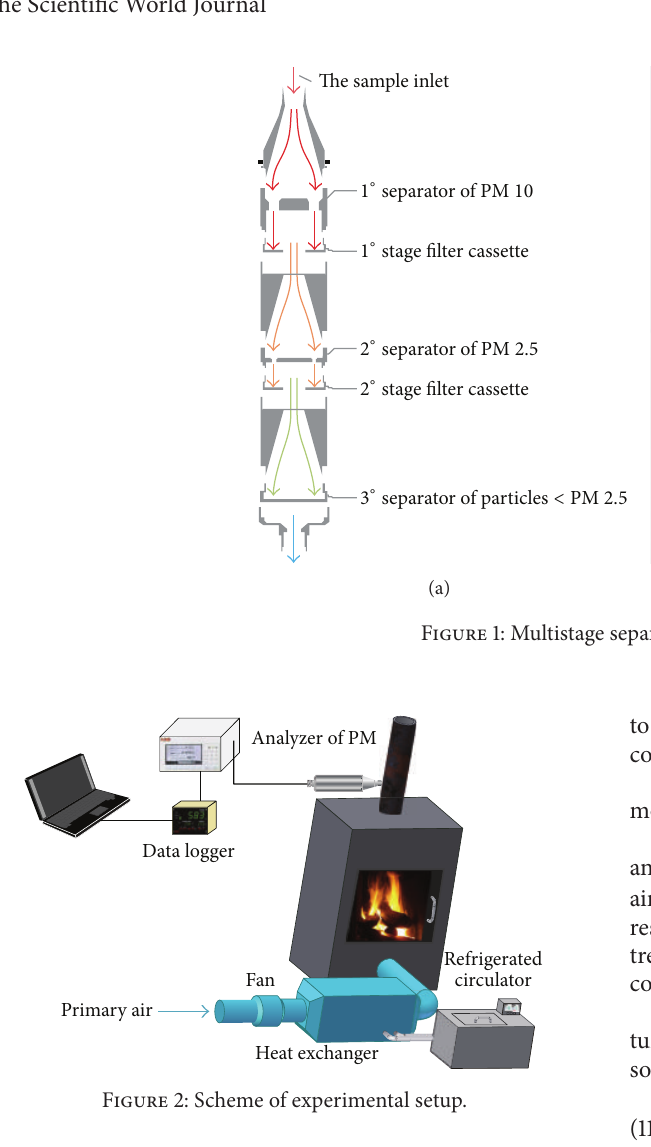
Table 1: Types of wood and their parameters. Type of